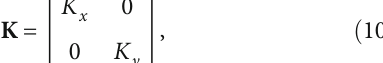
Figure 5: The velocity contour with streamlines for the 2nd order of the isotropic Sierpinski carpet models: (a) S1 ( D ( D = 1 : 934 ), (c) S2 ( D = 1 : 792 ), and (d) S11 ( D f f